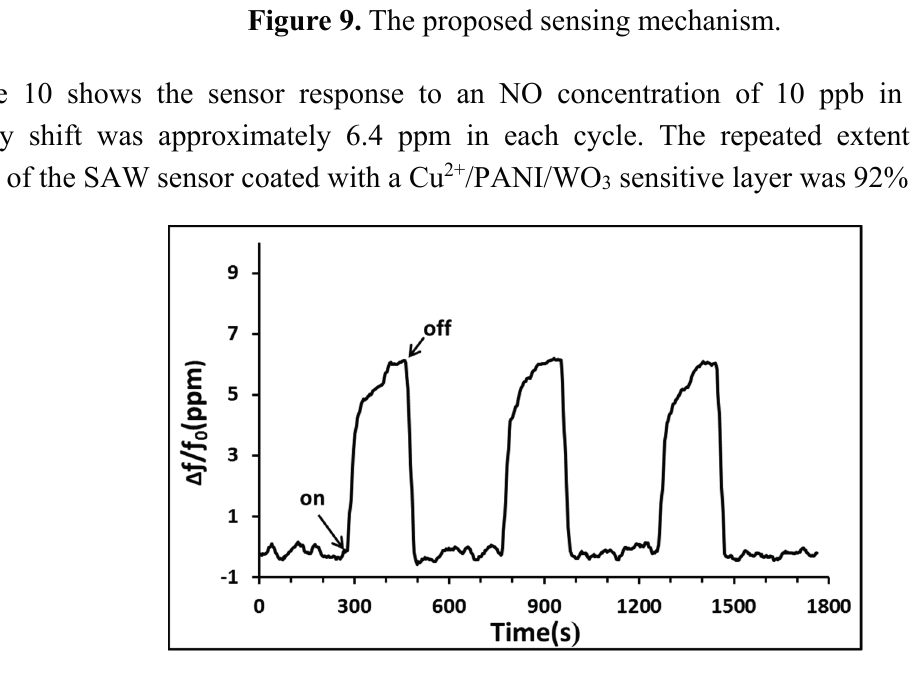
Figure 10. Frequency changes of the sensor at an NO concentration of 10 ppb in three gas on/off cycles using dry nitrogen as carrier gas at room